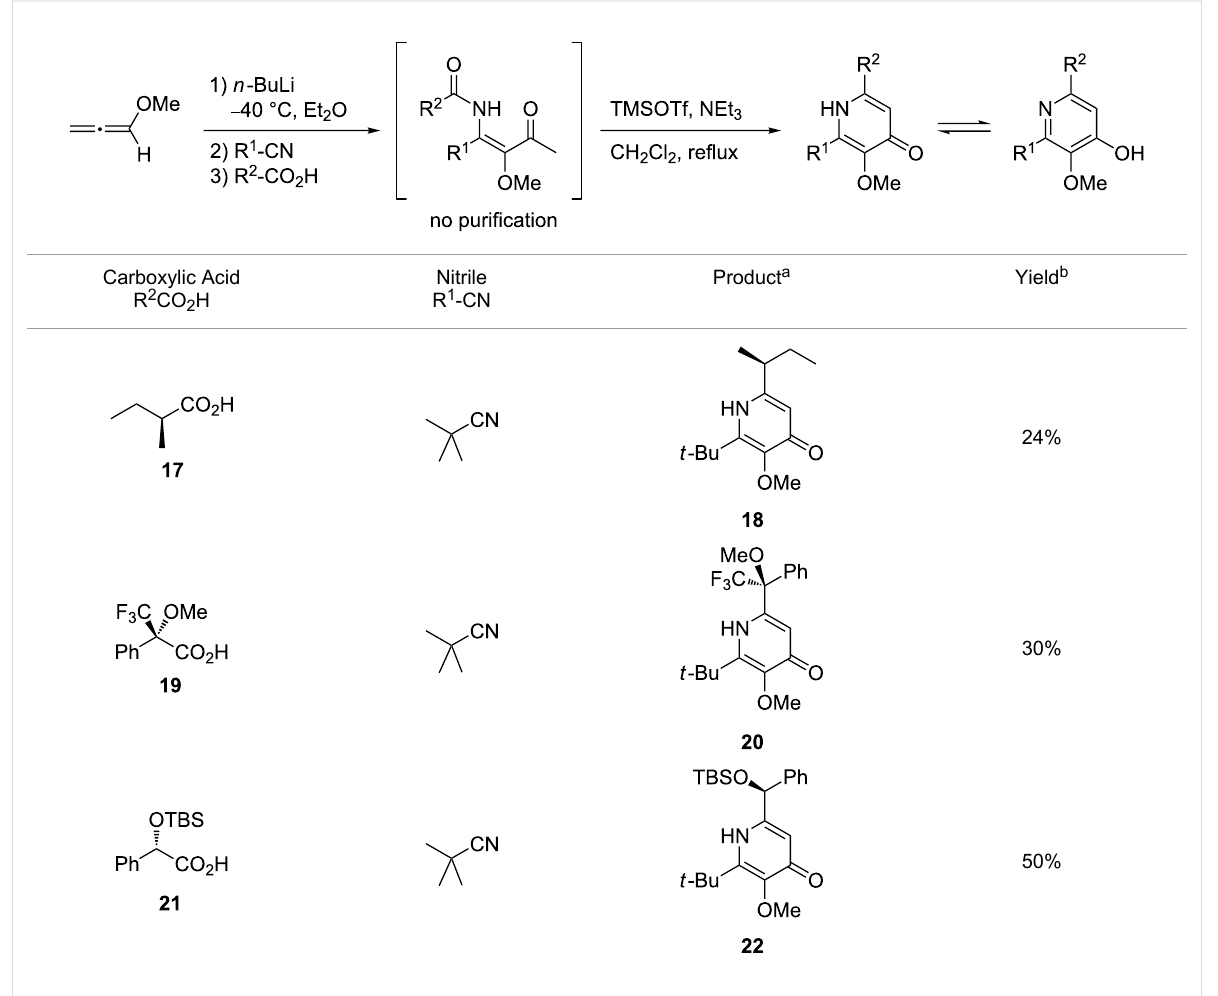
Table 1: Scope of the synthesis of 4-hydroxypyridine derivatives from lithiated methoxyallene, nitriles and carboxylic